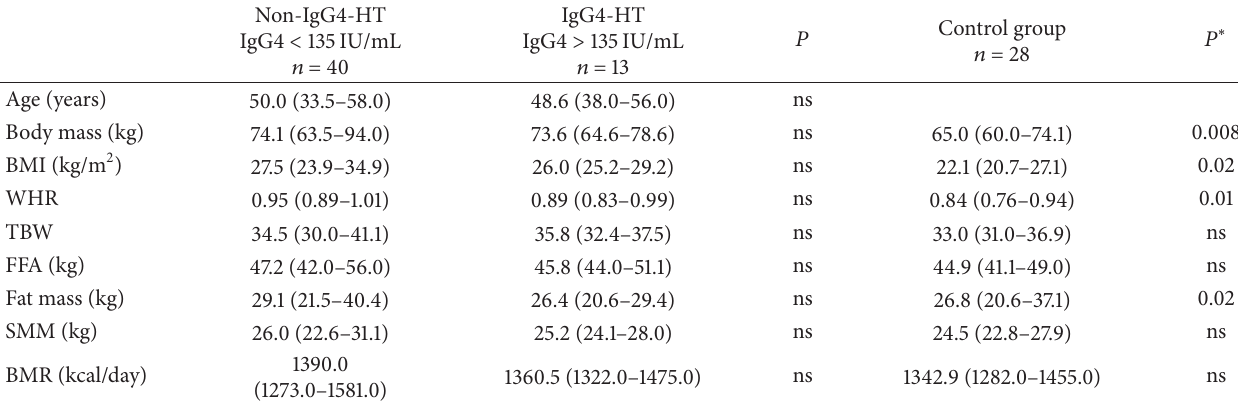
Table 2: Body composition analysis in patients with non-IgG4-HT and IgG4-HT compared with the control